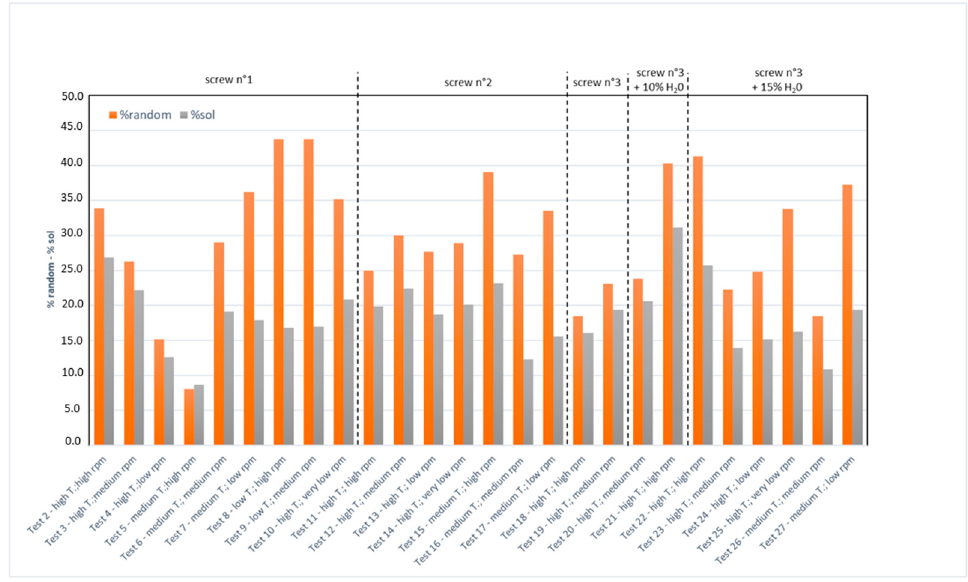
Figure 9. %sol and %random for all samples.